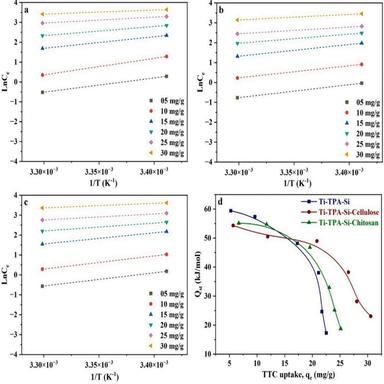
LnCe vs 1/T of TTC onto (a) Ti-TPA-Si, (b) Ti-TPA-Si-C, and (c) Ti-TPA-Si-CS, (d) isosteric heat of adsorption.